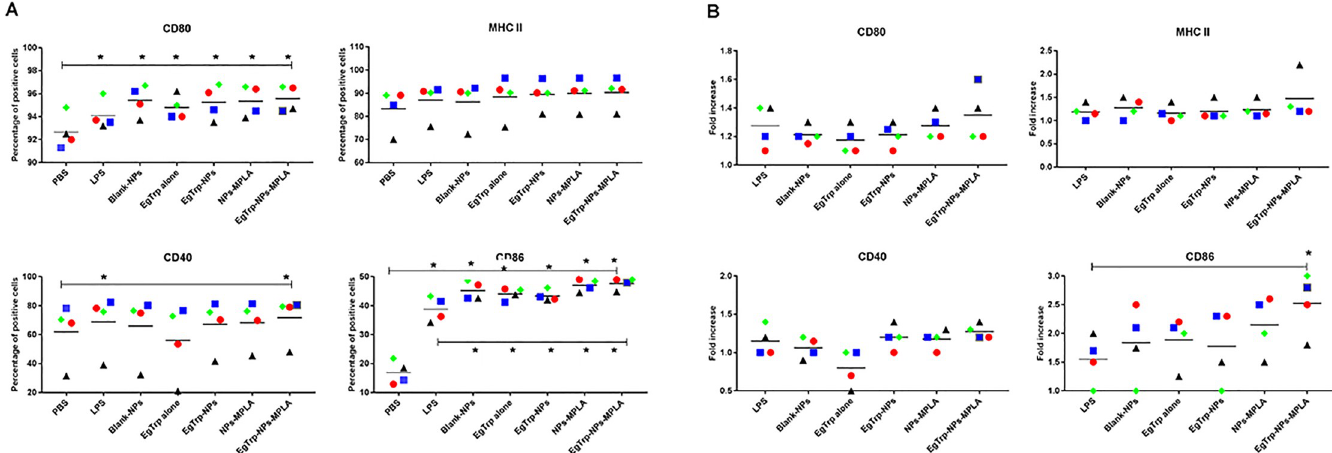
Fig 5. Measure of autologous TCD4+ proliferation by optical density at 450nm after incubation with CCK8. cMoDCs were previously challenged 24 h with PBS (negative control), LPS (positive control), Eg Trp alone, Blank-NPs, NPs-MPLA or Eg Trp-NPs-MPLA. � Significant difference p � 0.05.